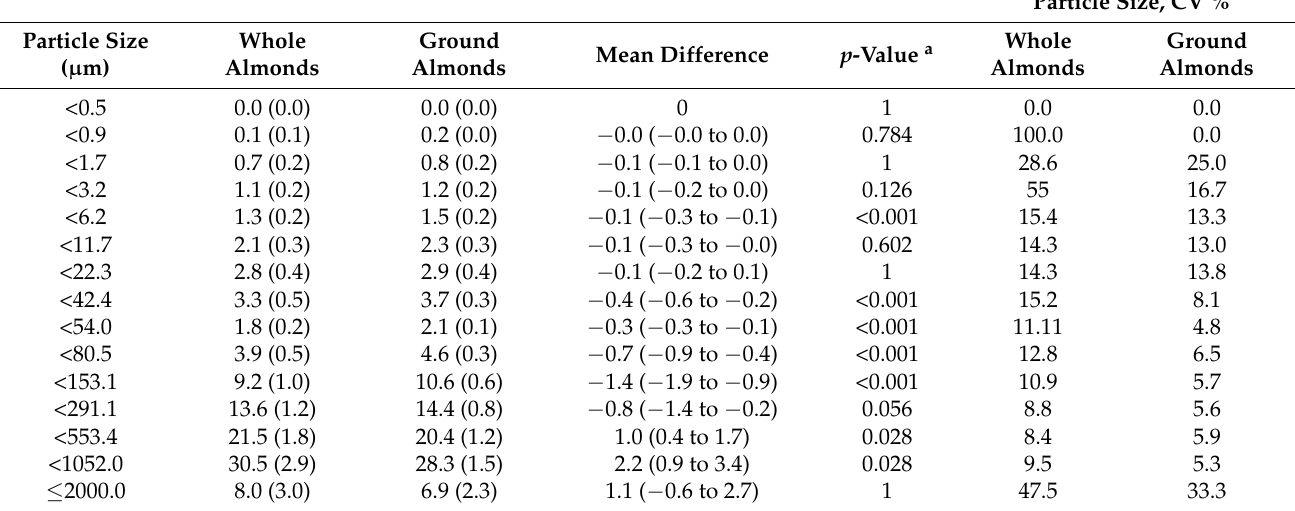
Table 4. Particle size distributions of masticated whole and ground almonds assessed by laser